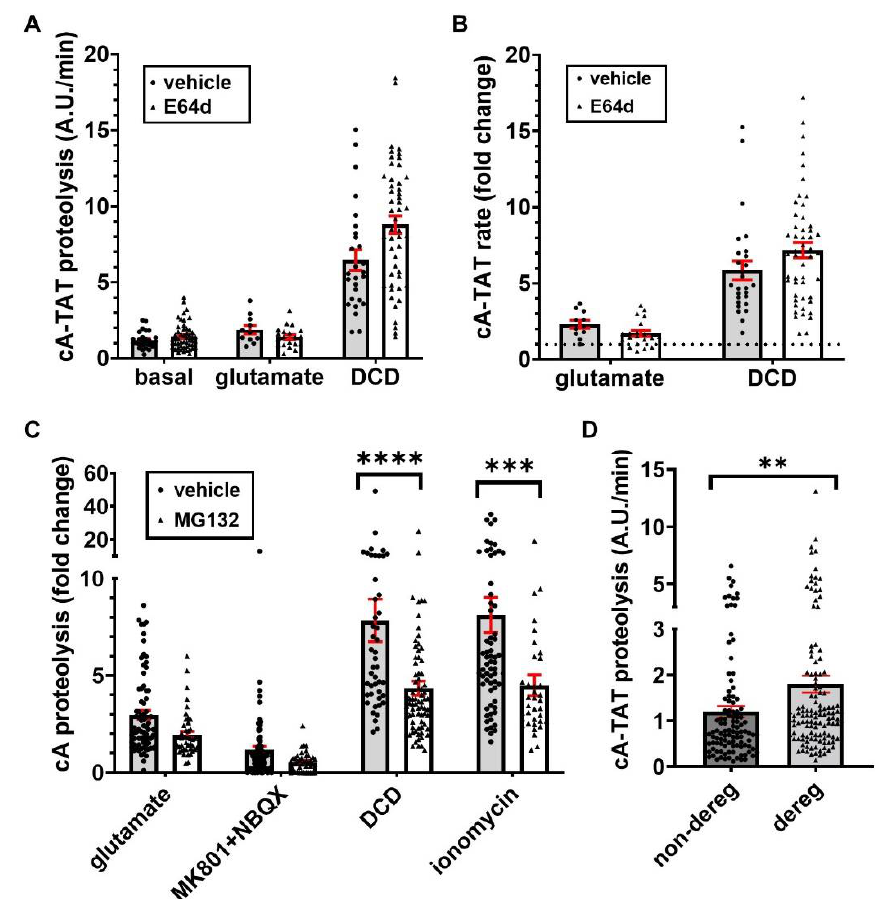
Figure 5. Indicated absolute ( A ) and baseline-normalized ( B ) cA-TAT rates in arbitrary units (A.U.)/min are shown in the presence of vehicle (0.1% DMSO) or cysteine protease inhibitor E64d (20 µM). In ( C ), the indicated baseline-normalized cA-TAT rates are shown in the presence of vehicle (0.2% DMSO) or protease inhibitor MG132 (20 µM). The graph in ( D ) compares the baseline cA-TAT proteolysis rates in cells that did or did not undergo Ca 2+ deregulation within two hours of excitotoxic glutamate (100 µM) addition in the experiment described in C, regardless of the pre-treatment (vehicle or MG132). The data are shown as means ± standard errors of the means (SEMs), with the individual data points indicating individual cells. ** denotes p < 0.01, determined by Welch’s unequal variances test. *** and **** denote p < 0.001 and p < 0.0001, respectively, determined by two-way ANOVA followed by Šídák’s multiple comparisons test.